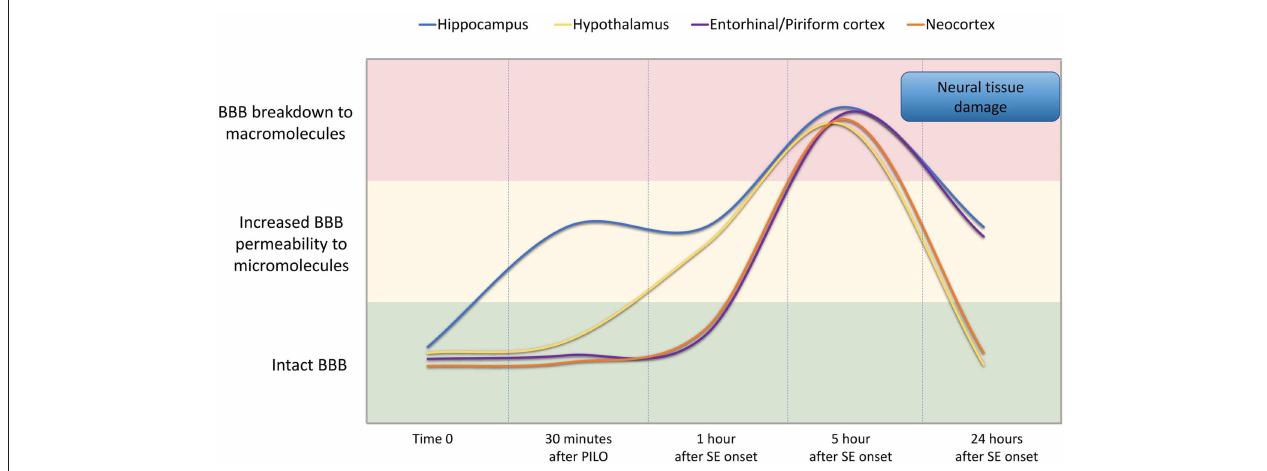
FIGURE 7 | Representation of BBB permeability during the acute phase of the pilocarpine model. The colored bands correspond to the BBB status: intact (green band), increased permeability to micromolecules (yellow band), and breakdown to macromolecules (red band). The lines represent the dynamics of the BBB opening and restoration over time in the regions of the hippocampus (blue line), hypothalamus (yellow line), entorhinal and pyriform cortex (purple line), and neocortex (orange line). Note that increased BBB permeability for micromolecules is observed from 30min after PILO injection, and the BBB breakdown for macromolecules occurs about 5h after SE onset. Although the BBB permeability to macromolecules is restored 24h after SE initiation, the leakage of micromolecules persists and the consequences of BBB degradation on brain tissue are widely disseminated in the